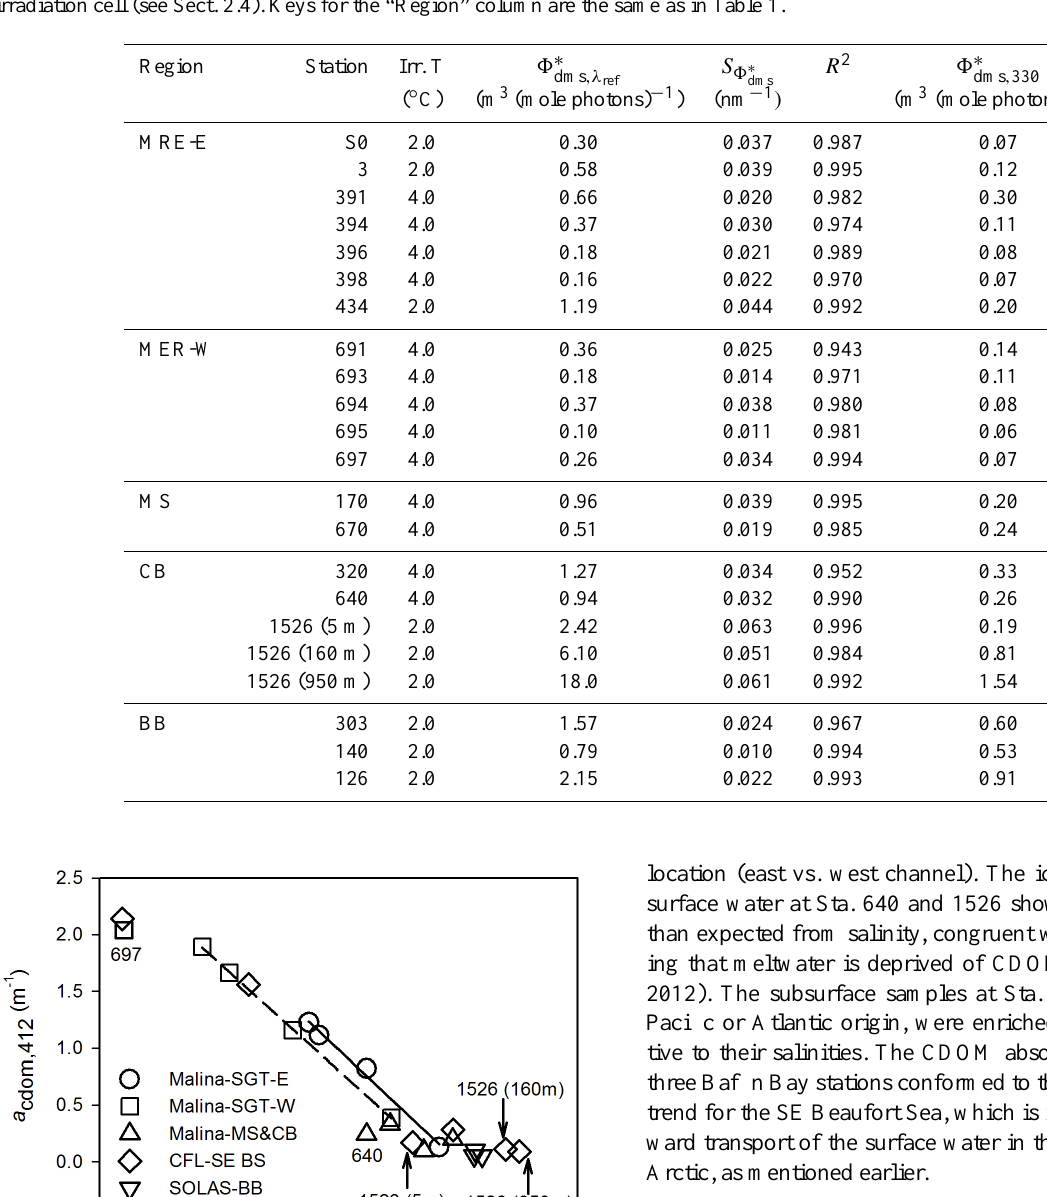
calculated from dms , 330